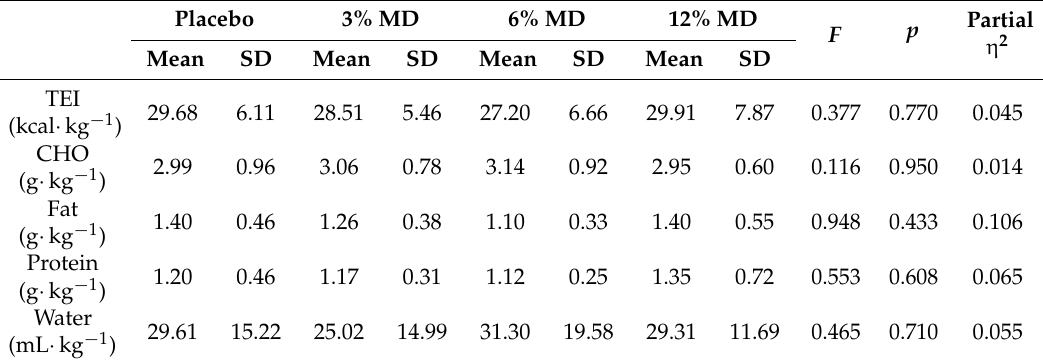
Table 1. Nutritional intake of the participants 24 h before the trials (values were presented per kg of body weight).